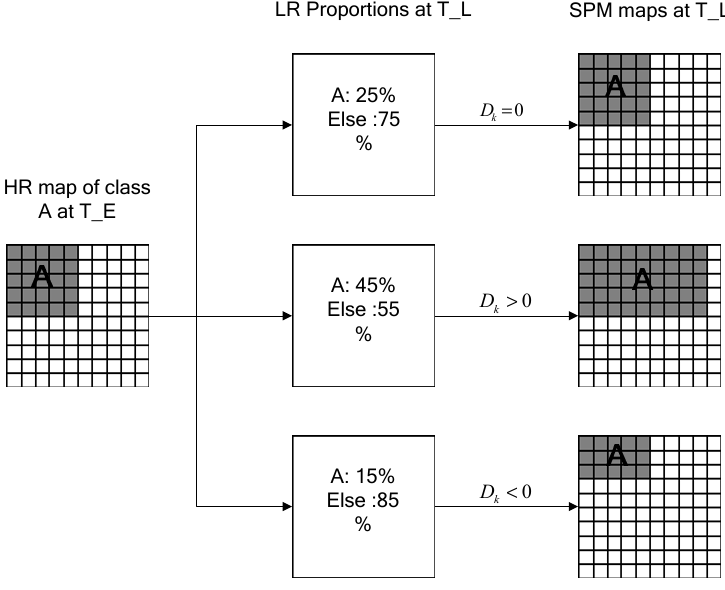
Figure 3. The illustration of the SLCCD_DR for three situations.